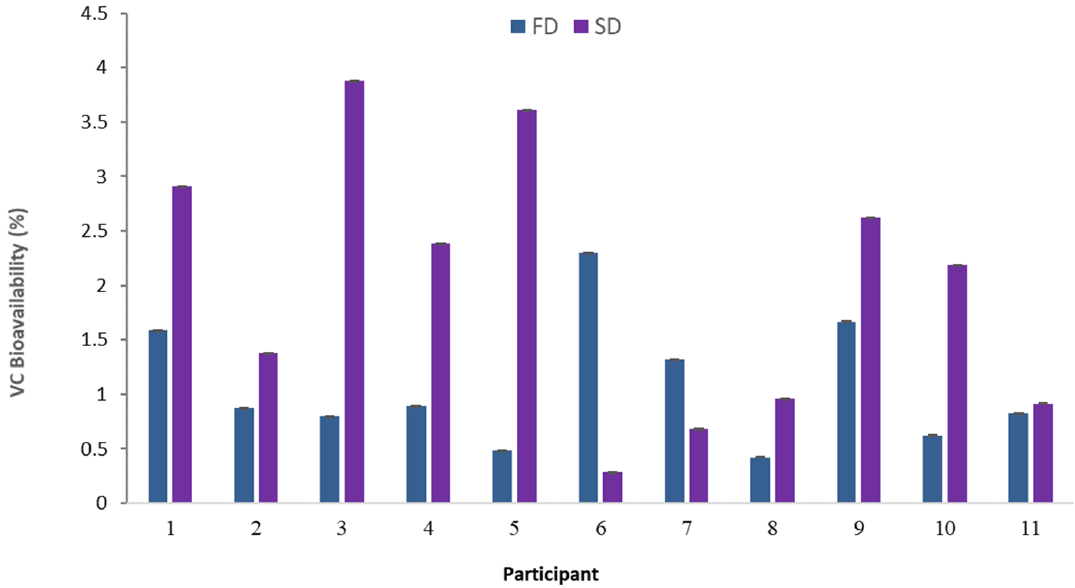
Figure 6. Vitamin C (VC) bioavailability (%) when ingested reconstituted freeze-dried (FDJ) and spray-dried (SDJ) juices. Values referred to mg VC recovered in the blood serum by 100 g of VC ingested.